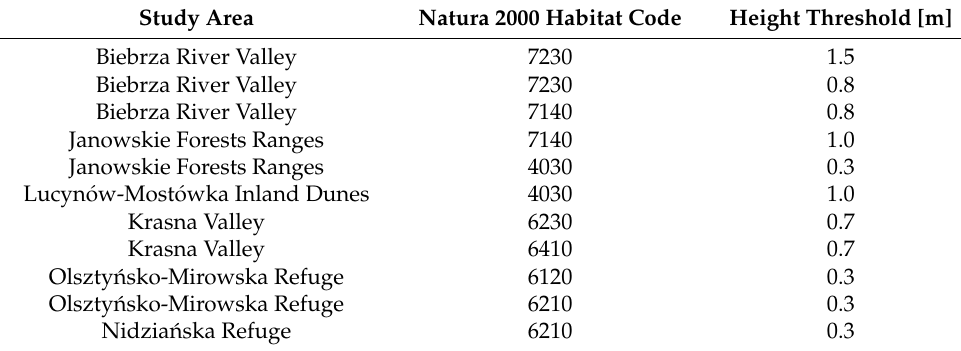
Table 7. Threshold values (minimum height of trees and shrubs) to determine the extent of trees and shrubs. Study Area Natura 2000 Habitat Code Height Threshold [m] Biebrza River Valley 7230 1.5 Biebrza River Valley 7230 0.8 Biebrza River Valley 7140 0.8 7140